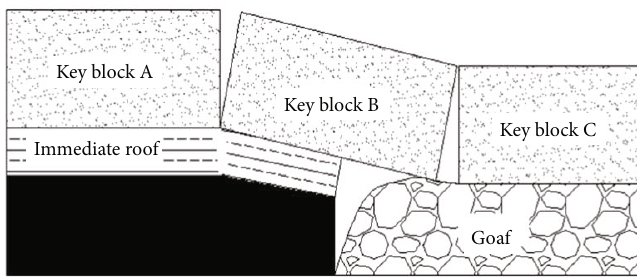
Figure 3: Structural characteristics of overburden for the conventional working